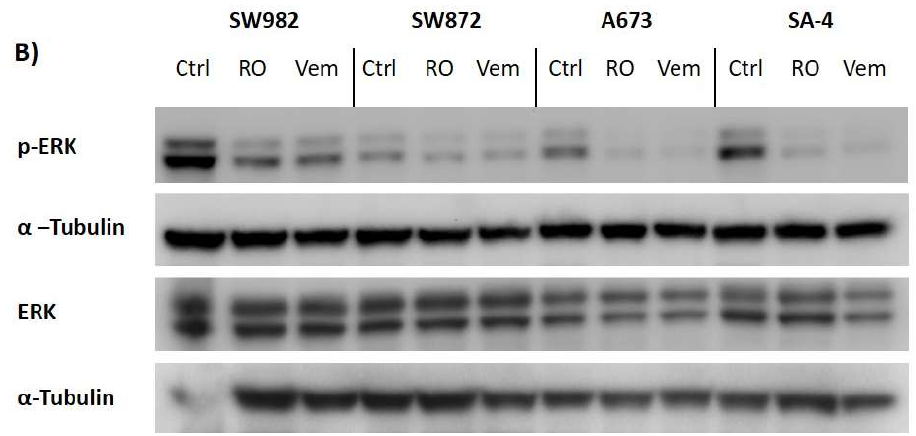
Figure 7. Vemurafenib inhibits ERK phosphorylation in sarcoma cell lines. Four BRAF V600E mutated sarcoma cell lines were treated with 5 µM vemurafenib, 300 nM RO5126766 or vehicle only (Ctrl) for either ( A ) 3 h or ( B ) 72 h, before levels of phosphorylated ERK (p-ERK) in cell lysates were analyzed by western blotting, using indicated antibodies. α-Tubulin served as protein loading control.